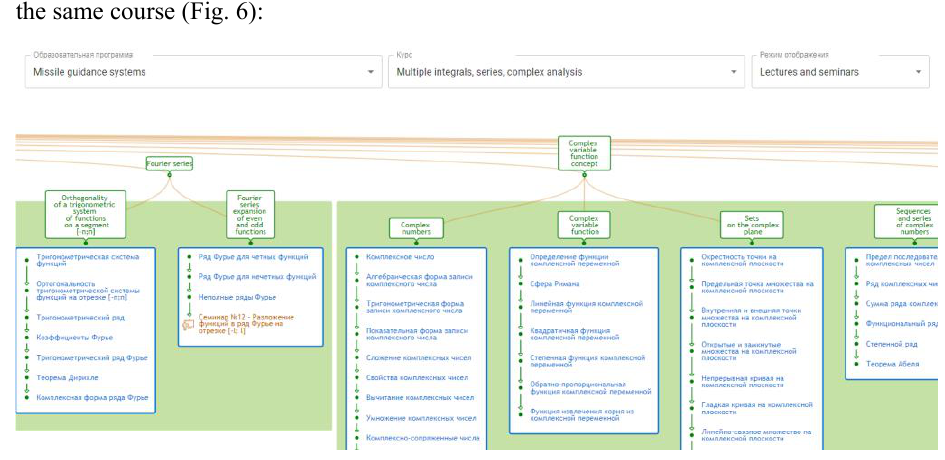
Fig. 6. The course "Multiple Integrals, Series, Complex Analysis".